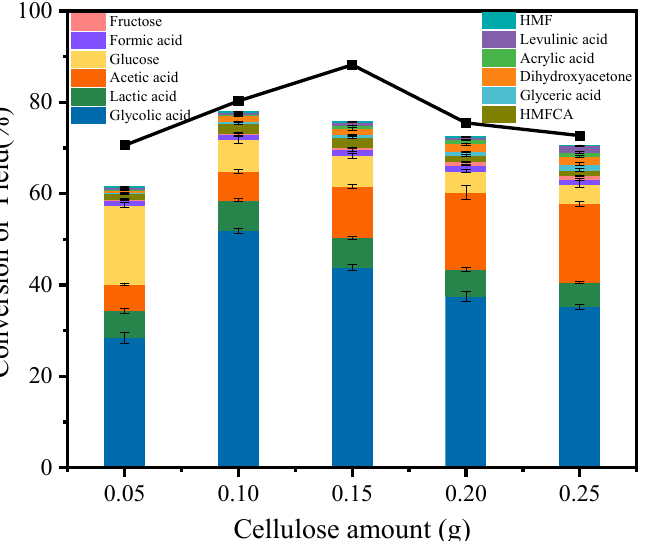
Figure 12. The effects of cellulose amounts on the catalytic activity of Bi/ β -2 catalyst. Reaction conditions: Bi/ β -2 0.08 g, water 12 mL, 180 ◦ C, 10 h, 2 MPa O 2 .